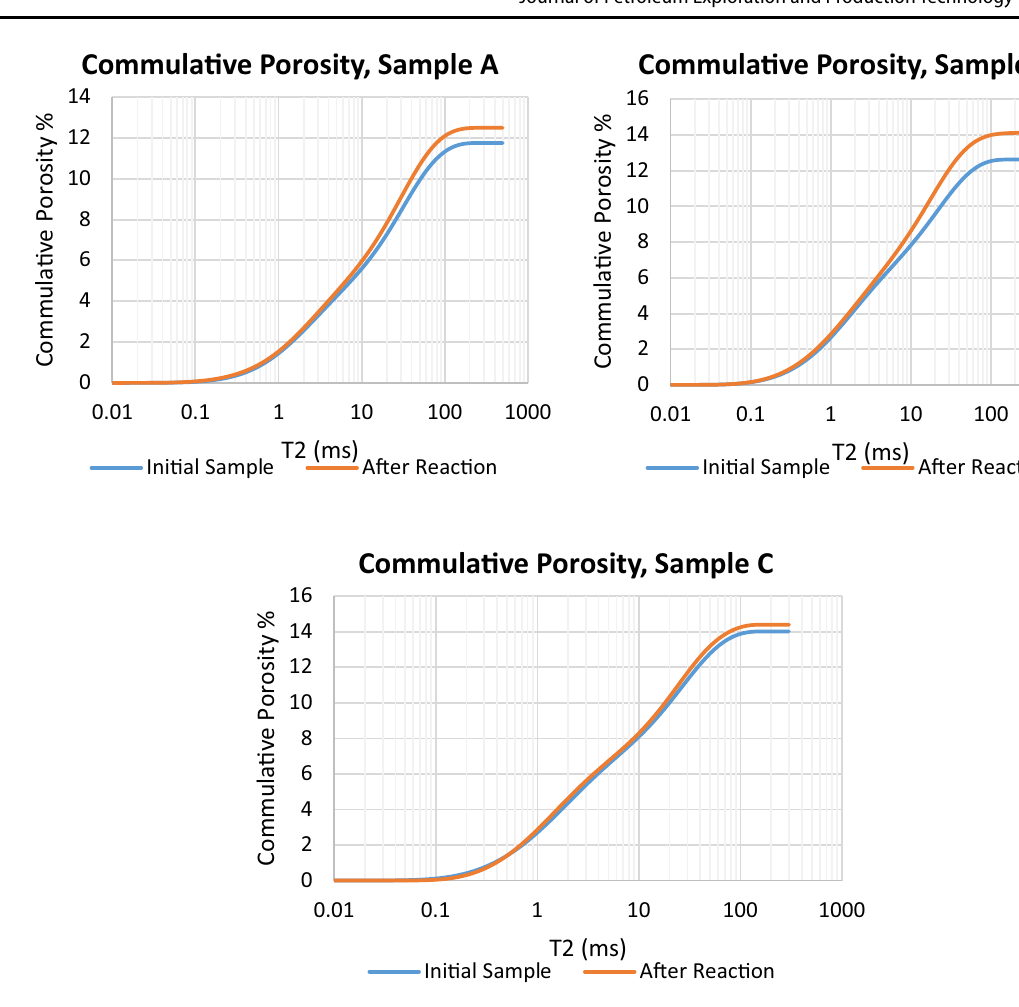
Fig. 13 T2 commulative spectrum of all Colton sandstone core samples before and after reaction with